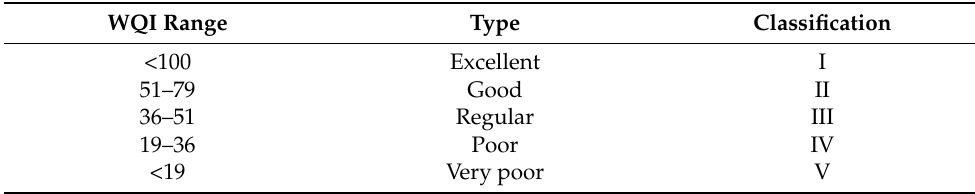
Table 1. Classification of the Water Quality Index